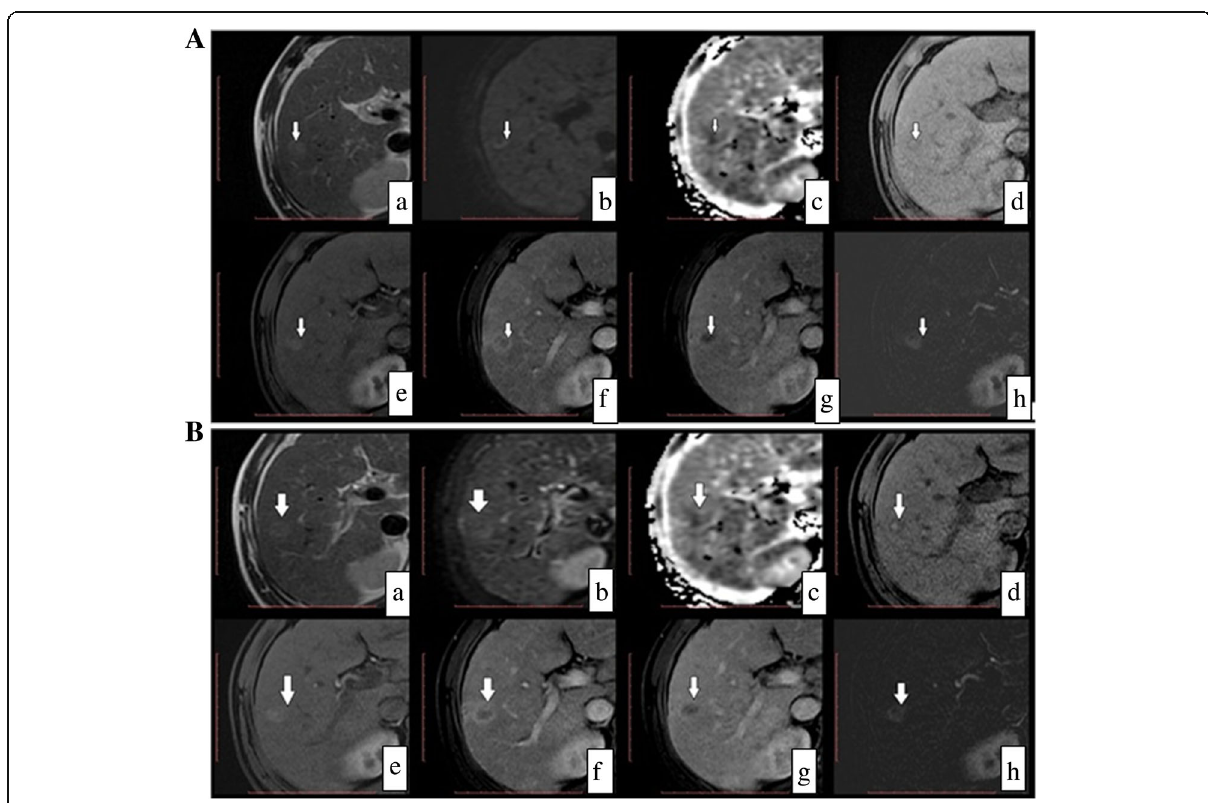
Fig. 2 A 67-year-old male patient with hepatitis-related liver cirrhosis and single segment V/VI HCC lesion. He had a TACE session and came for follow up 1 month post TACE and another short term follow up after 2 months. (A) Follow up dynamic MRI 1 month post TACE. a T2WI, b DWI image, c ADC image, d T1WI, e late arterial phase, f portal phase, g delayed phase, and h late arterial subtracted image. The treatment zone exhibits high signal in T1WIs and intermediate to high signal in T2WIs with thick peripheral area of enhancement suggestive of residual disease. Subtraction clarified this pattern of enhancement by removing the native high T1WIs signal. (B) Short-term follow up dynamic MRI 2 months post TACE. a T2WI, b DWI image, c ADC image, d T1WI, e late arterial phase, f portal phase, g delayed phase, and h late arterial subtracted image. Note that the lesion appears with same pattern of contrast enhancement and slight increase in size confirming the residual